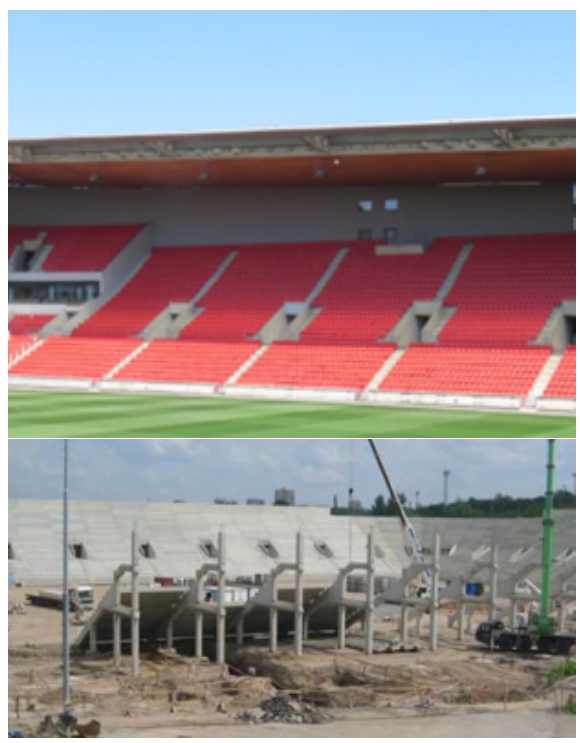
Figure 1. Platform construction: a) Eden Stadium – the overall view [5], b) Eden Stadium detail